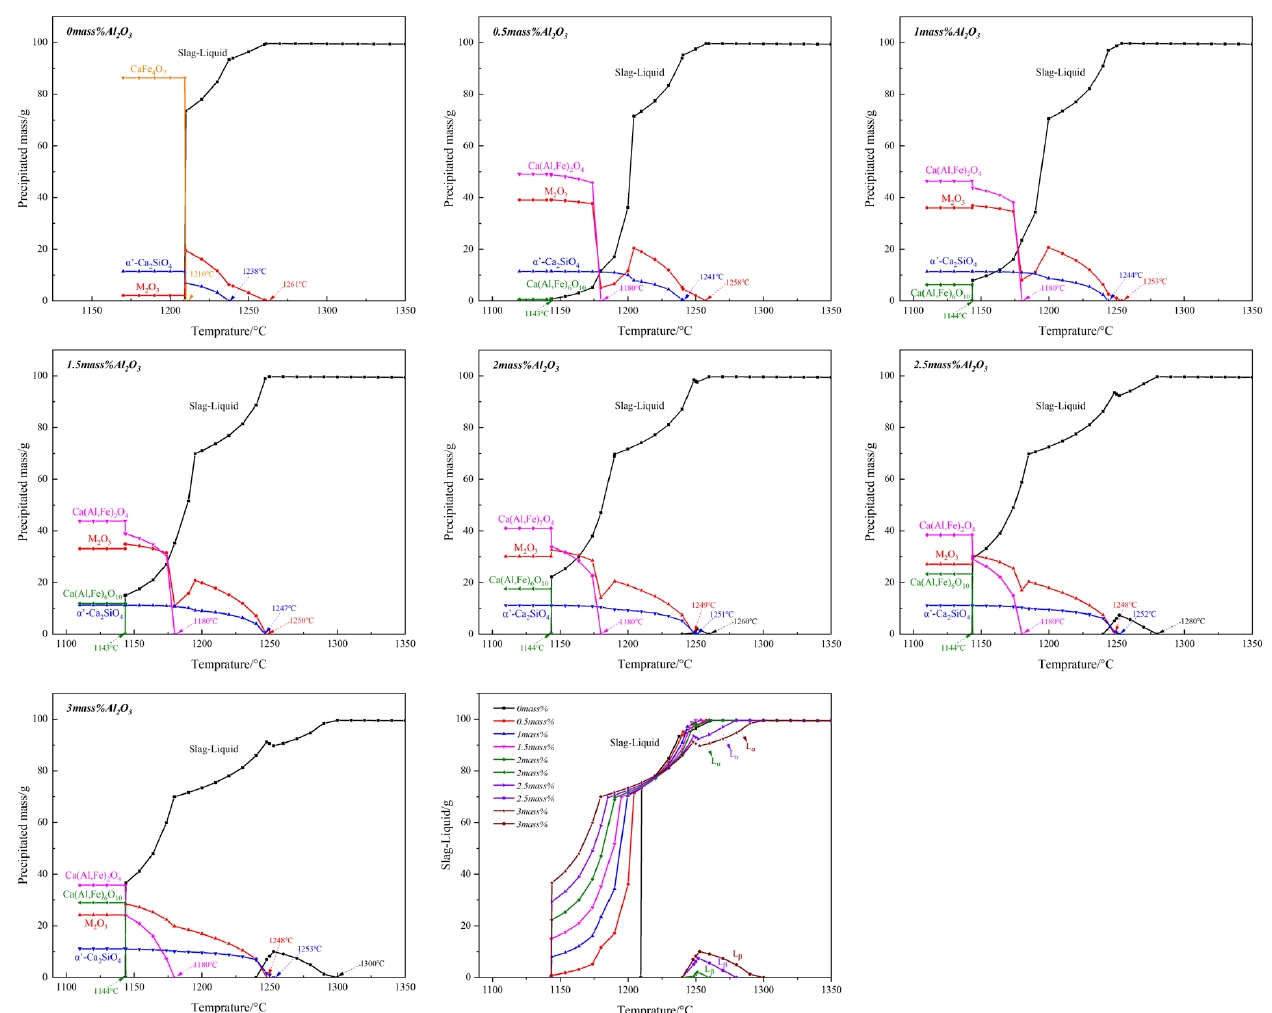
Figure 14. Theoretical crystal phase composition of Fe 2 O 3 -CaO-SiO 2 -Al 2 O 3 slag during Table 6. Changes of primary crystallization phase and temperature after adding Al 2 O 3 .